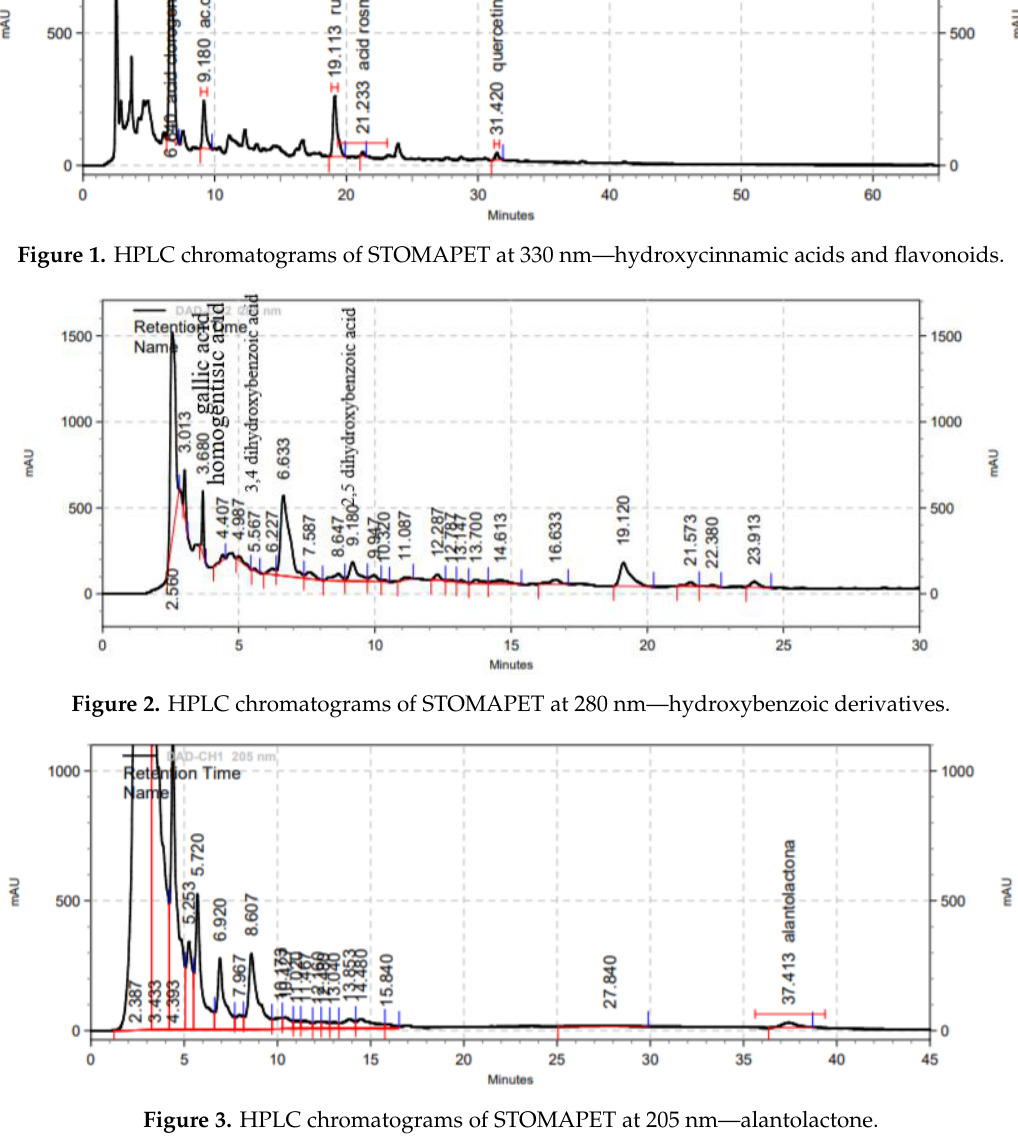
Figure 4. The effect of STOMAPET on SC cells exposed for 24 and 48 h (MTS assay). Values represent mean ± SD (n = 3, * p < 0.05, ** p < 0.01, *** p < 0.001). In LPS-stimulated macrophages, the product induced a protective effect only at high doses and only after 24 h of exposure. After 48 h, cells viability dropped close to the LPS group level. (Figure 5).